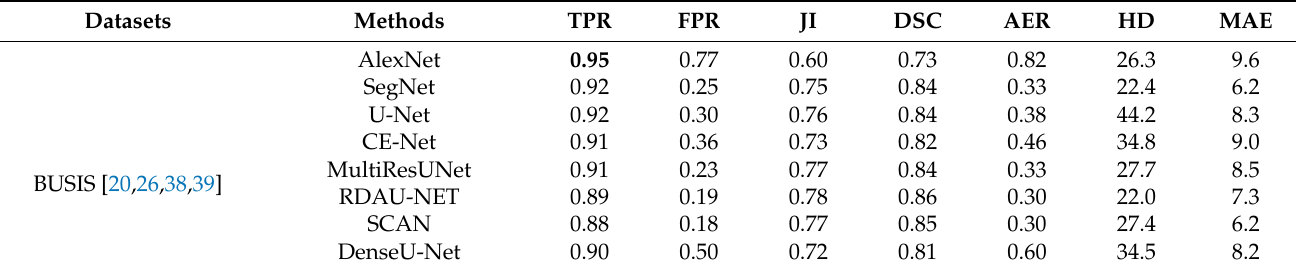
Figure 6. False positive rates of overall and small tumor segmentation on the three datasets. Table 3. Performance of small tumor segmentation. The bold results are the best achieved perfor- mance according to a particular metric.